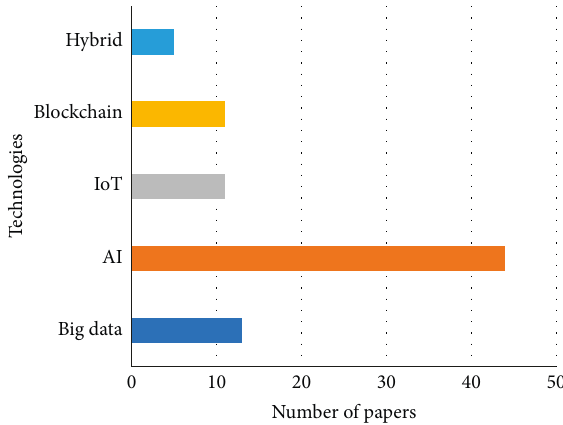
Figure 4: Statistics of the papers based on the